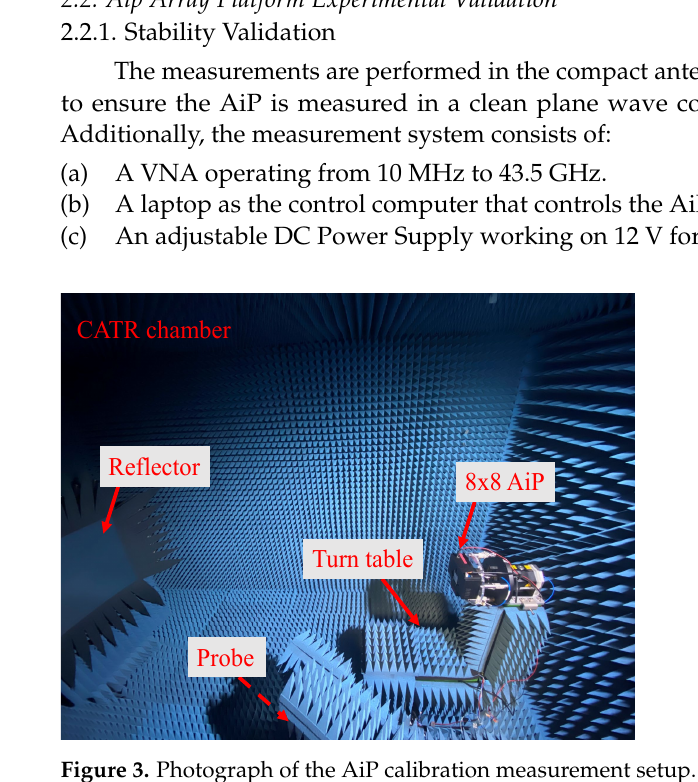
Figure 3. Photograph of the AiP calibration measurement